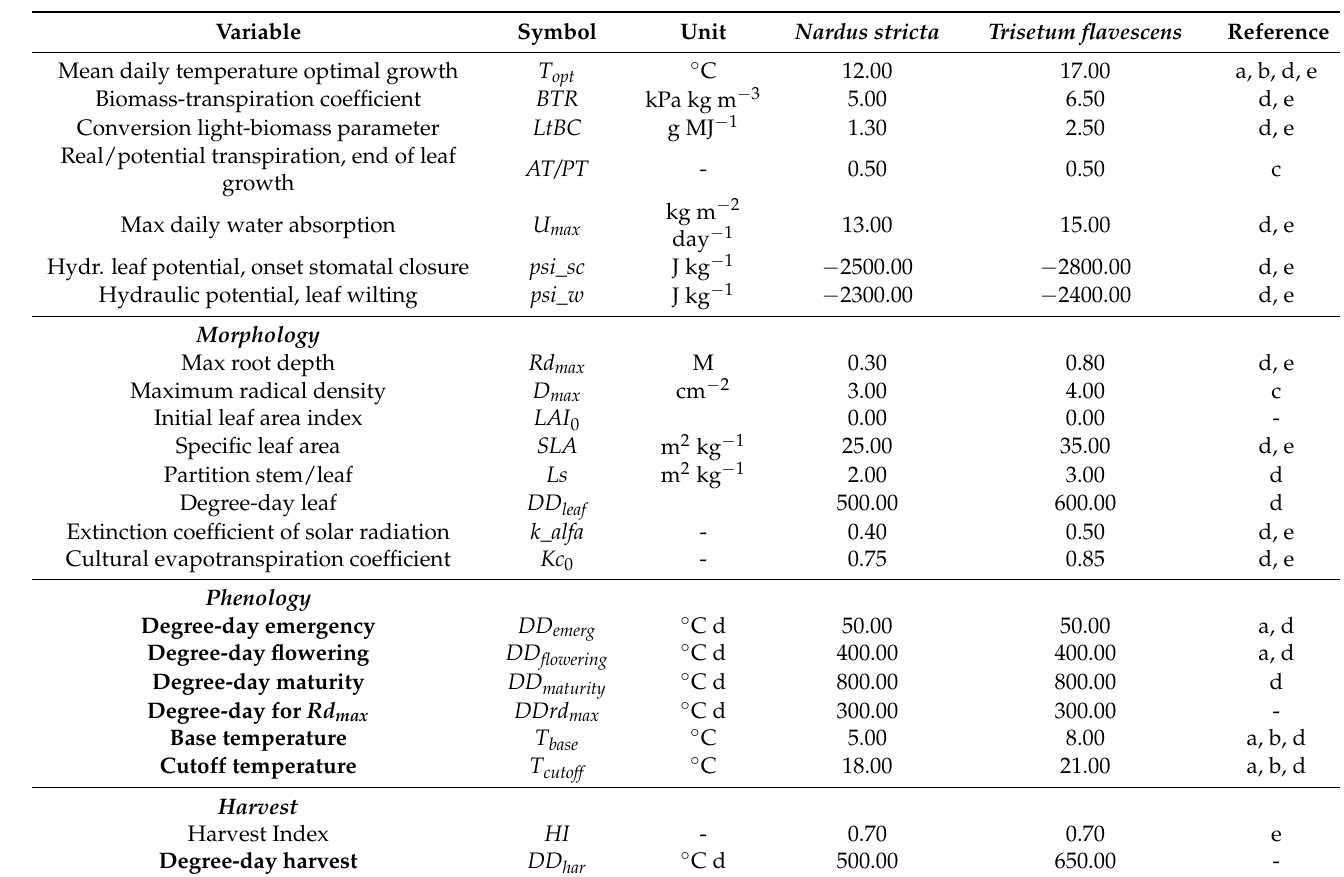
Table 2. Poli-Pasture module parameters: their value for Nardus stricta and Trisetum flavescens . Parameters in bold calibrated against yield data from ISTAT. Other parameters taken based